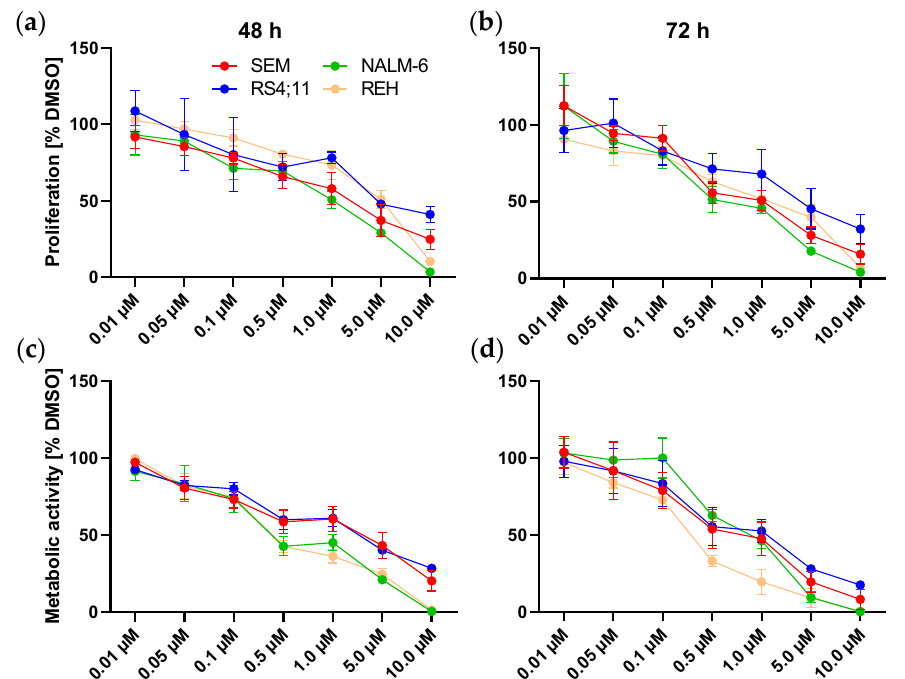
Figure 2. Effects of MK-2206 incubation on cell proliferation and metabolic activity. Dose-response curves of SEM, RS4;11, REH and NALM-6 cells incubated with increasing concentrations of MK-2206 for 48 h ( a , c ) and 72 h ( b , d ). Proliferation ( a , b ) was assessed by trypan blue staining and metabolic activity ( c , d ) was determined by WST-1 assay. Mean ± standard deviation of at least three individual biological replicates. Significance was determined by student’s t test after testing Gaussian distribution. To increase clarity, significance levels are not indicated within the graphs and instead listed in Supplementary Tables S1–S4.